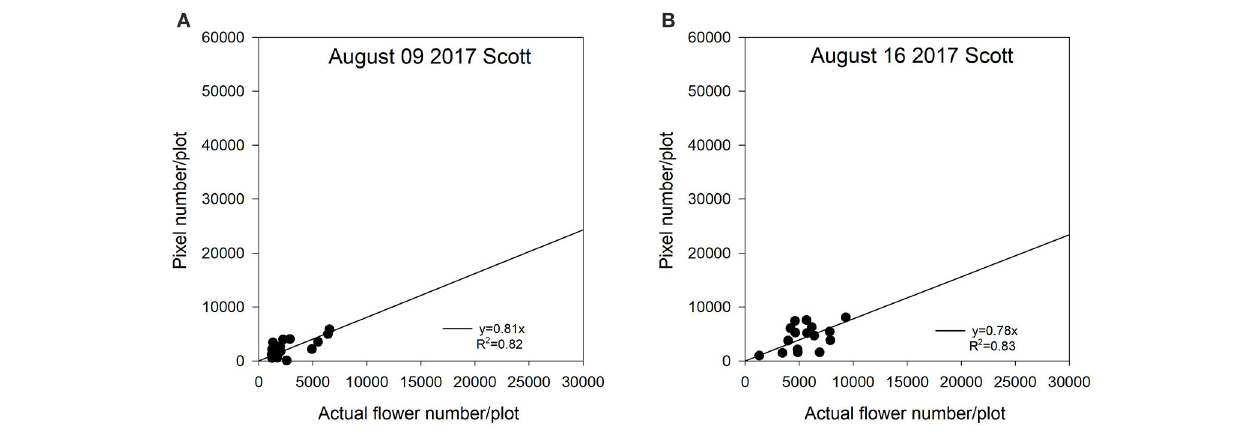
FIGURE 7 | The relationship between actual flower numbers per plot and pixel numbers extracted from aerial images during the flowering stage at Scott, SK, Canada in 2017. Actual flower numbers per plot were manually measured. Pixel number per plot was detected by the thresholding method. (A) Regression equation for August 09, 2017: y = 0.81x, R 2 = 0.82. (B) Regression equation for August 16, 2017: y = 0.78x, R 2 = 0.83.